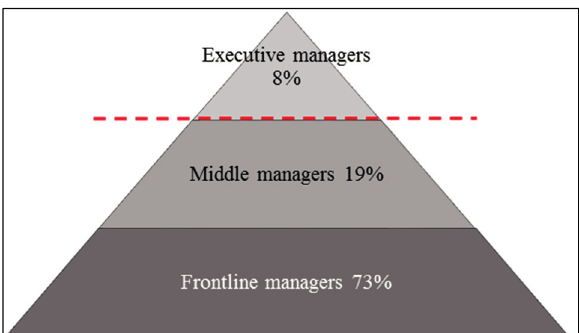
Figure 1. Reorganizing teams at the